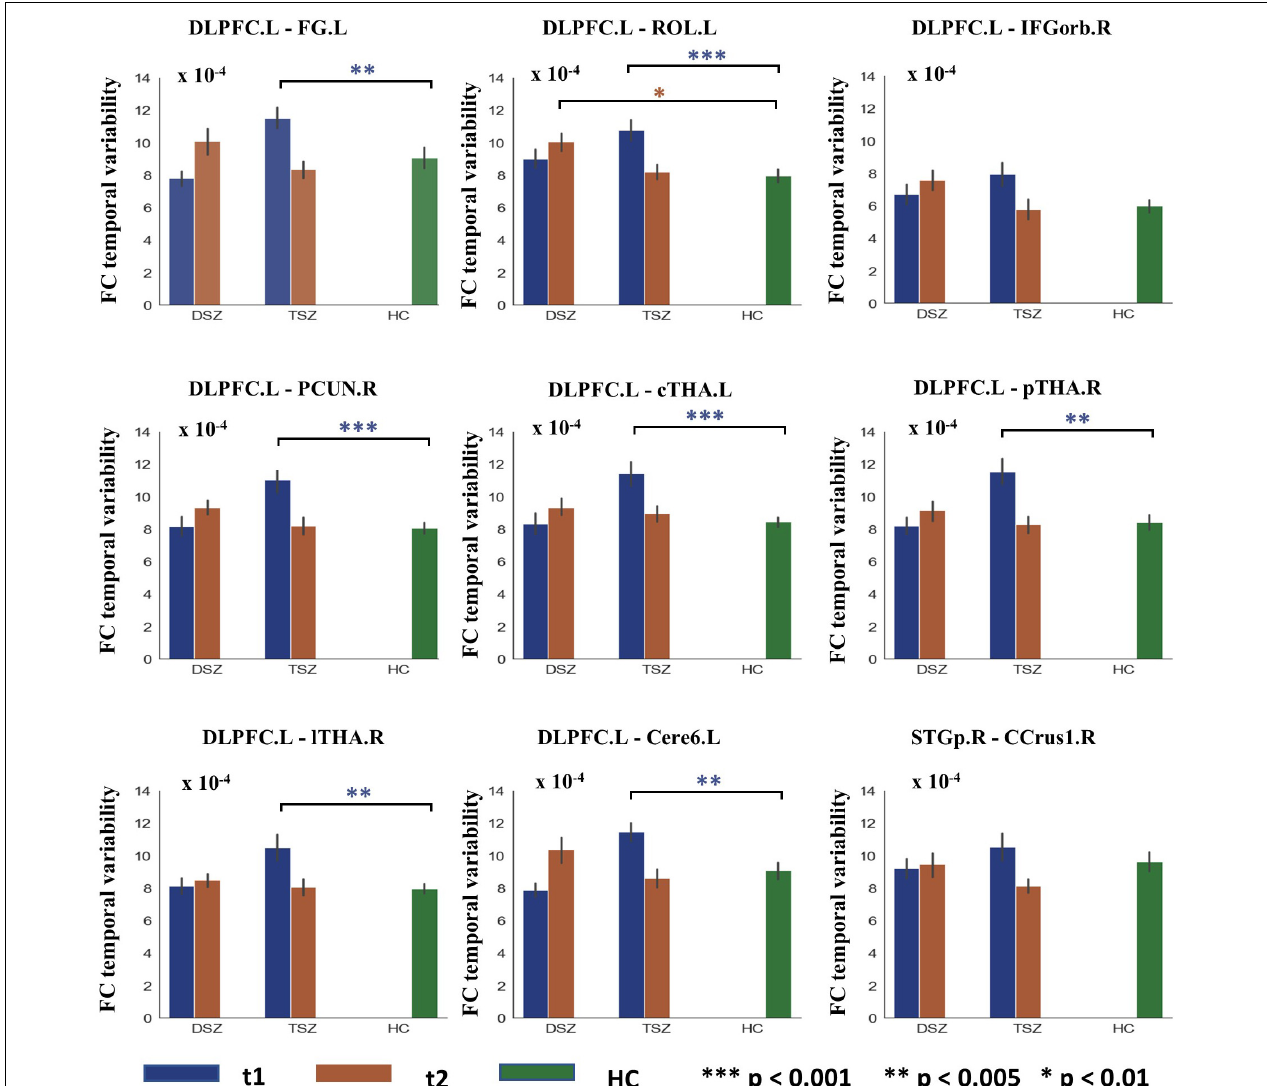
FIGURE 3 | Group differences in ROI-wise functional connectivity (FC) temporal variability between TSZ, DSZ, and HC groups at post- and pre-rTMS interventions. Different numbers of * indicate different levels of significance. * p < 0.01; ** p < 0.005; *** p < 0.001. DLPFC.L, left dorsolateral prefrontal cortex. Other abbreviations for ROIs can be found in Supplementary Table 1